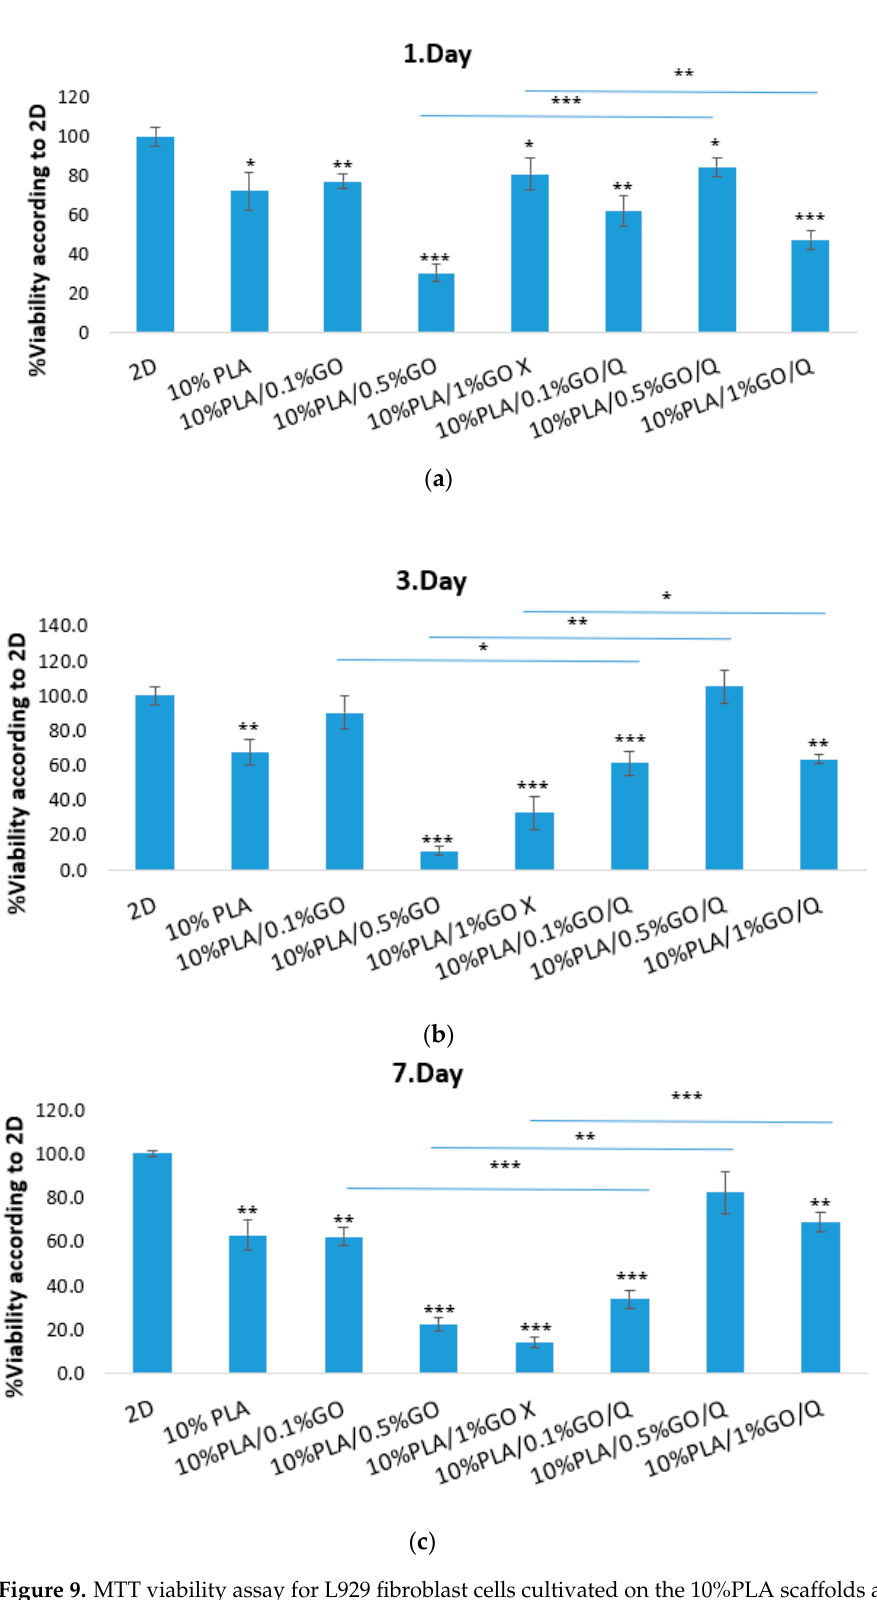
Figure 9. MTT viability assay for L929 fibroblast cells cultivated on the 10%PLA scaffolds at different time intervals; 1 day ( a ), 3 days ( b ) and 7 days ( c ), respectively; data is presented as ±SD. The mark “*” indicates significant difference at p < 0.05, “**” p < 0.01 and “***” p < 0.001.